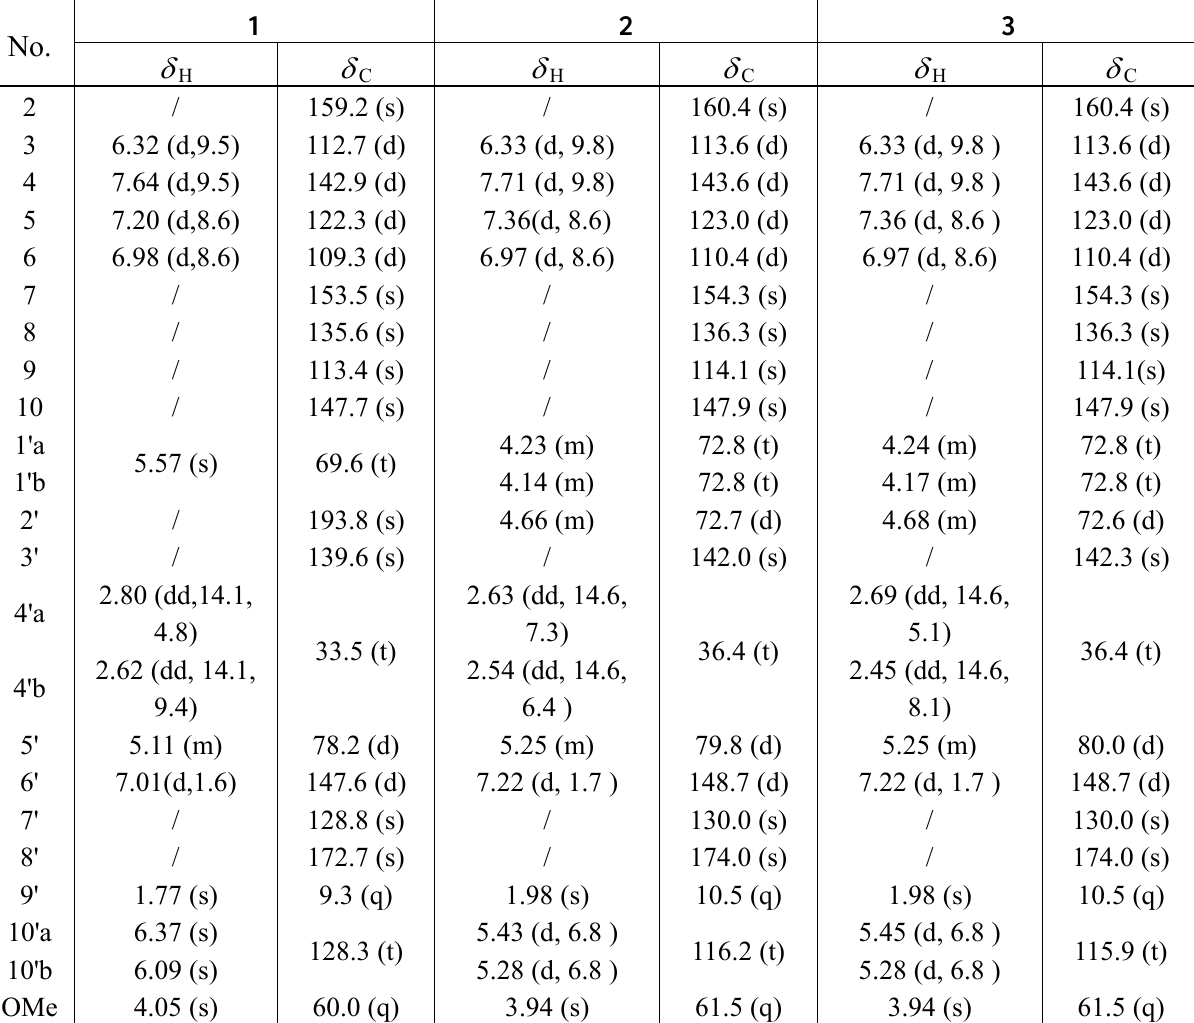
Table 1. The 1 H- and 13 C-NMR data for compounds 1 - 3 ( δ in ppm, J in Hz)*.